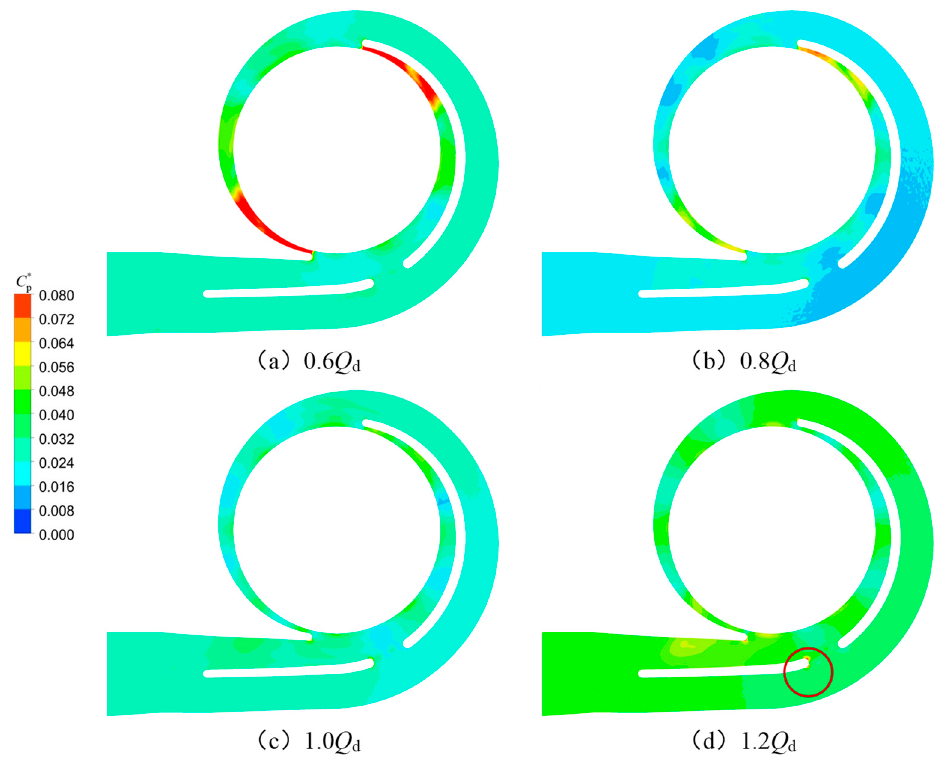
Figure 11. Pressure fluctuation intensity distribution on the mid-span of the volute under different fl ow rates.